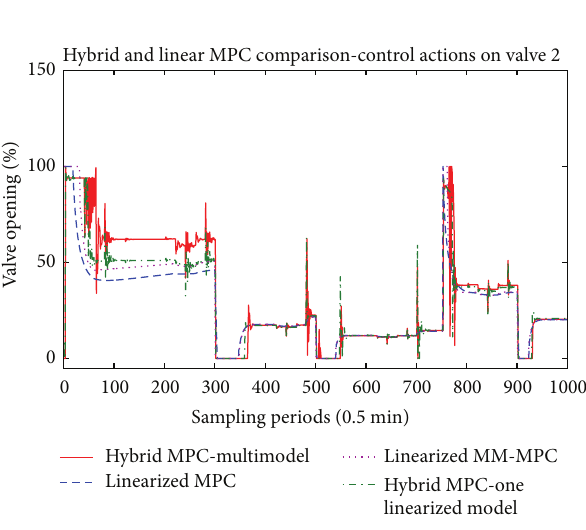
Figure 9: Control actions of the second valve.